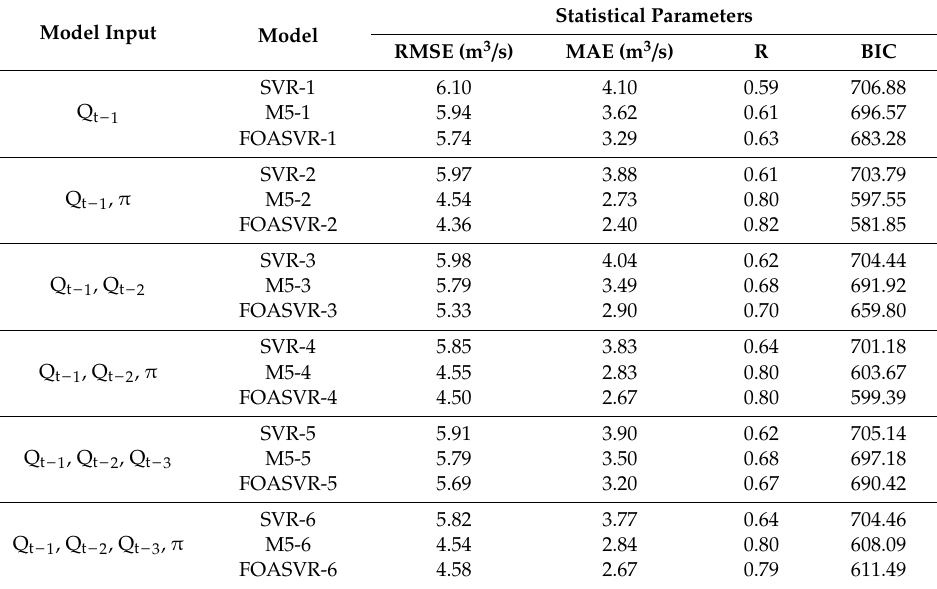
Table 3. The evaluation parameters of studied models in the test period for Babarud